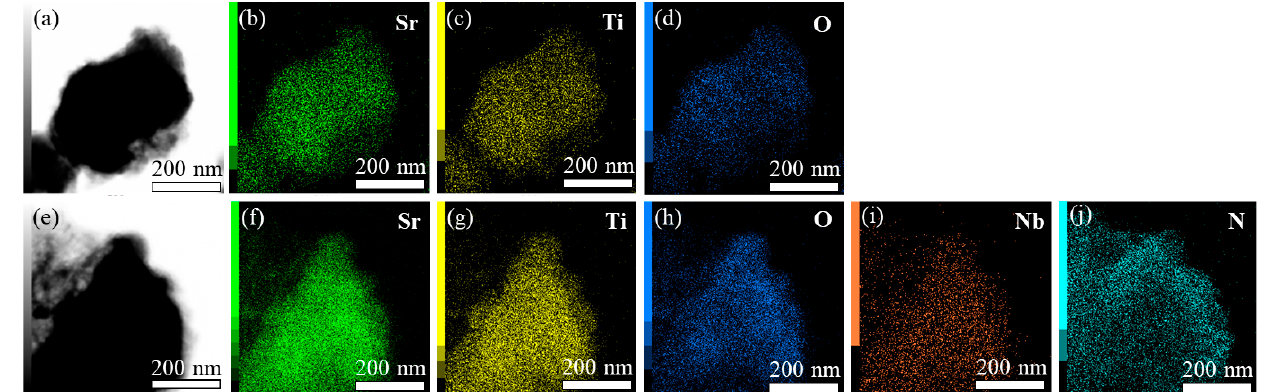
Figure 3. ( a ) TEM image of Sr 2 TiO 4 ; ( b – d ) Elemental mapping of Sr, Ti, and O; ( e ) TEM image of Sr 2 TiO 4 :N,Nb(2%); ( f – j ) Elemental mapping of Sr, Ti, O, Nb, and N.